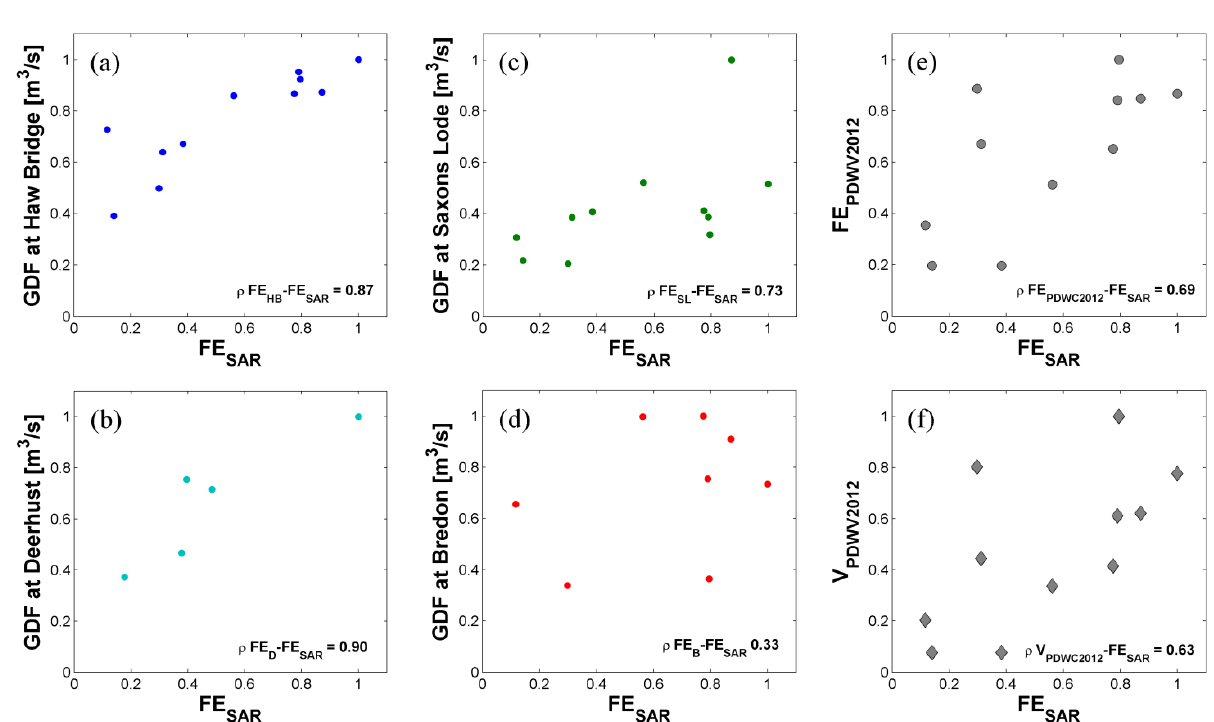
Figure 5. Correlation between FE SAR and hydrological variables in the rectangular AOI: ( a ) GDF at Haw Bridge; ( b ) GDF at Deerhust; ( c ) GDF at Saxons Lode; ( d ) GDF at Bredon; ( e ) FE PDWC2012 ; ( f ) V PDWC2012